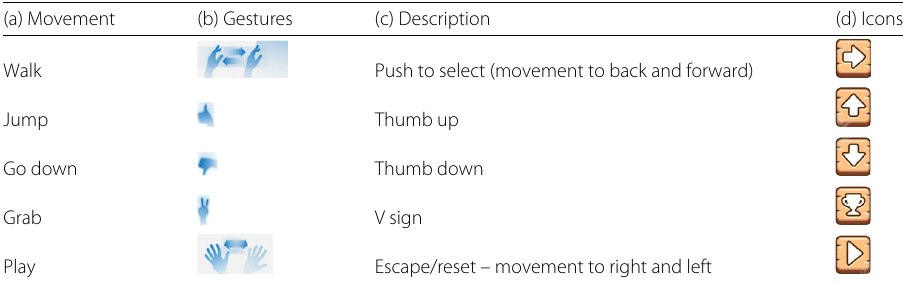
Table 1 Mapping of the hand gestures and icons to the movements - (a) Pirate movements/actions, (b) Hand gestures, (c) Hand gestures descriptions, (d) Icons representing the movements/actions (a) Movement (b) Gestures (c) Description (d) Icons Walk Push to select (movement to back and forward) Jump Thumb up Go down Thumb down Grab V sign Play Escape/reset – movement to right and